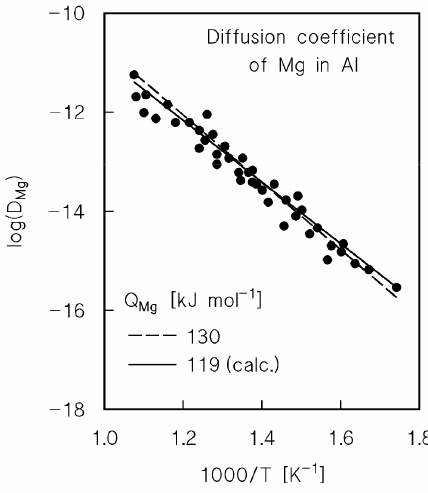
Figure 2. Diffusion coefficient in Al-Mg (set of literature data from [19]). The Figure illustrates the best fitting of the data as well as the curve representing the diffusion coefficient used in the majority of previous